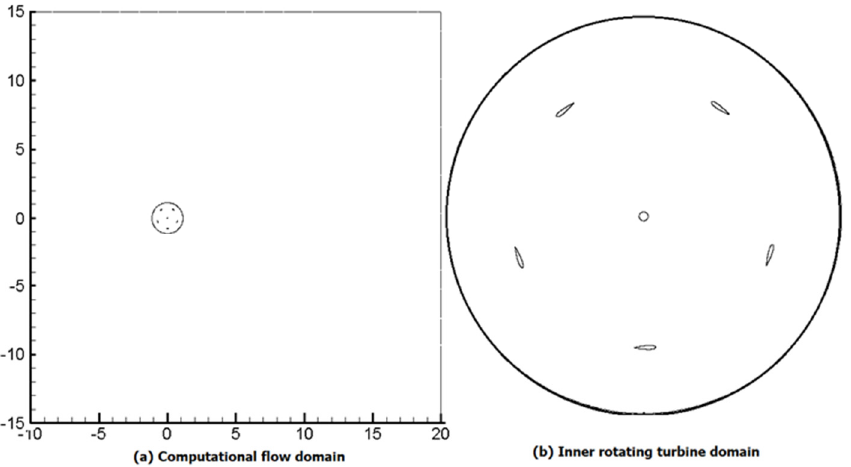
Figure 16. ( a ) The CFD domain and ( b ) the turbine model.